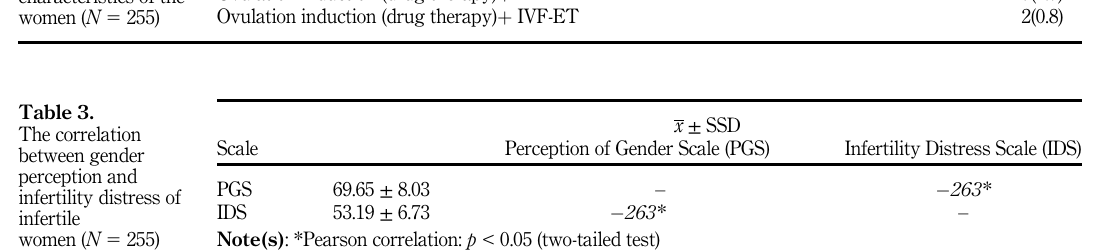
characteristics of the women ( N 5 255)